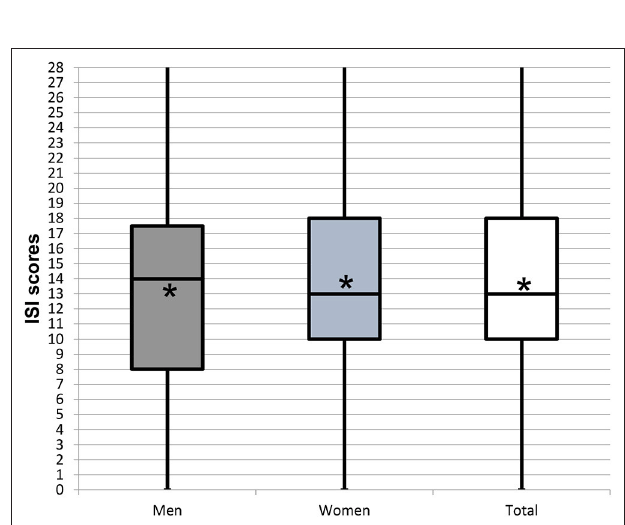
( Table 1 ; Figures 1 , 2 ). Also the gender ratios of 1:2.3, 1:2.2, and 1:2.6, respectively, were similar among the three populations. This mean age and the gender ratio corresponds to a